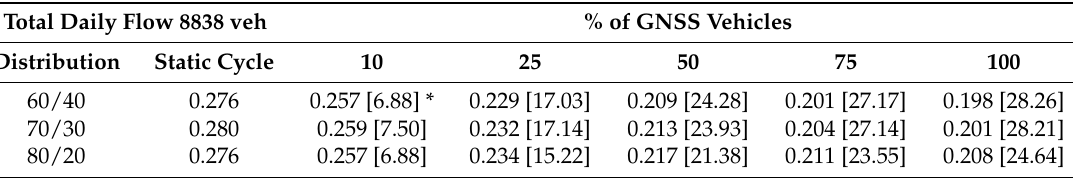
Table 6. Average fuel consumption [l/km], in a typical day, for Case